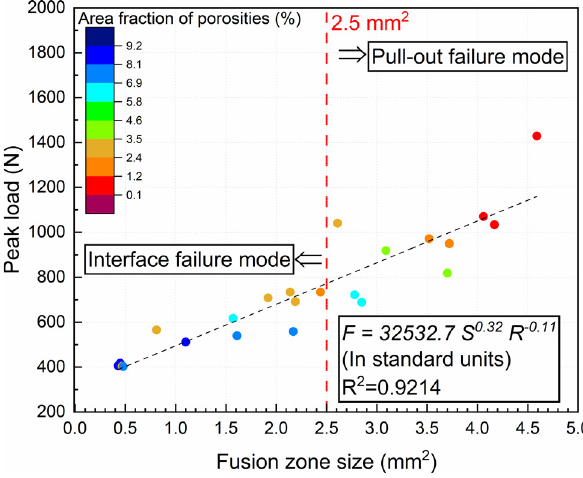
Figure 10: Effect of fusion zone size (S) and area fraction of porosi- ties (P) on the peak load of tensile shear tests